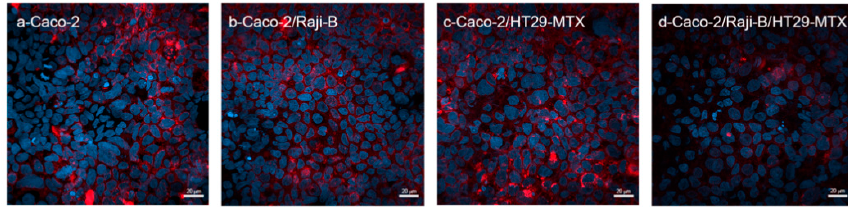
Figure 2. CLSM analysis of WGA expression (red) in the different (co)culture conditions at 21st day of culture. Caco-2 mono-culture; Caco-2/Raji B co-culture; Caco-2/HT29-MTX co-culture; Caco-2/HT29-MTX/Raji B tri-culture. Nuclei were counterstained with DAPI (blue). Bars, 20 μ m.